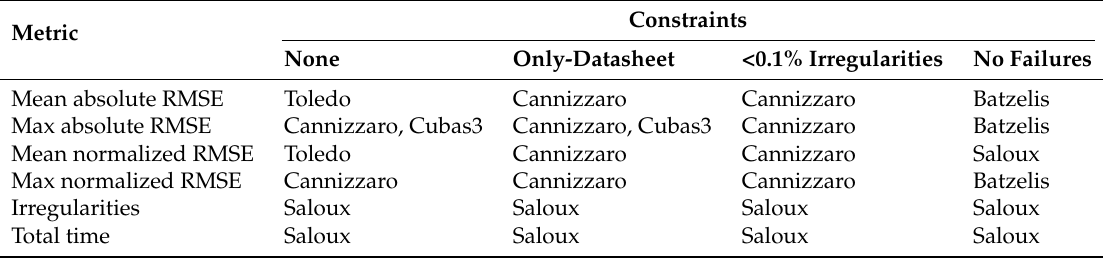
Table 7. Methods with the best universal performance regarding